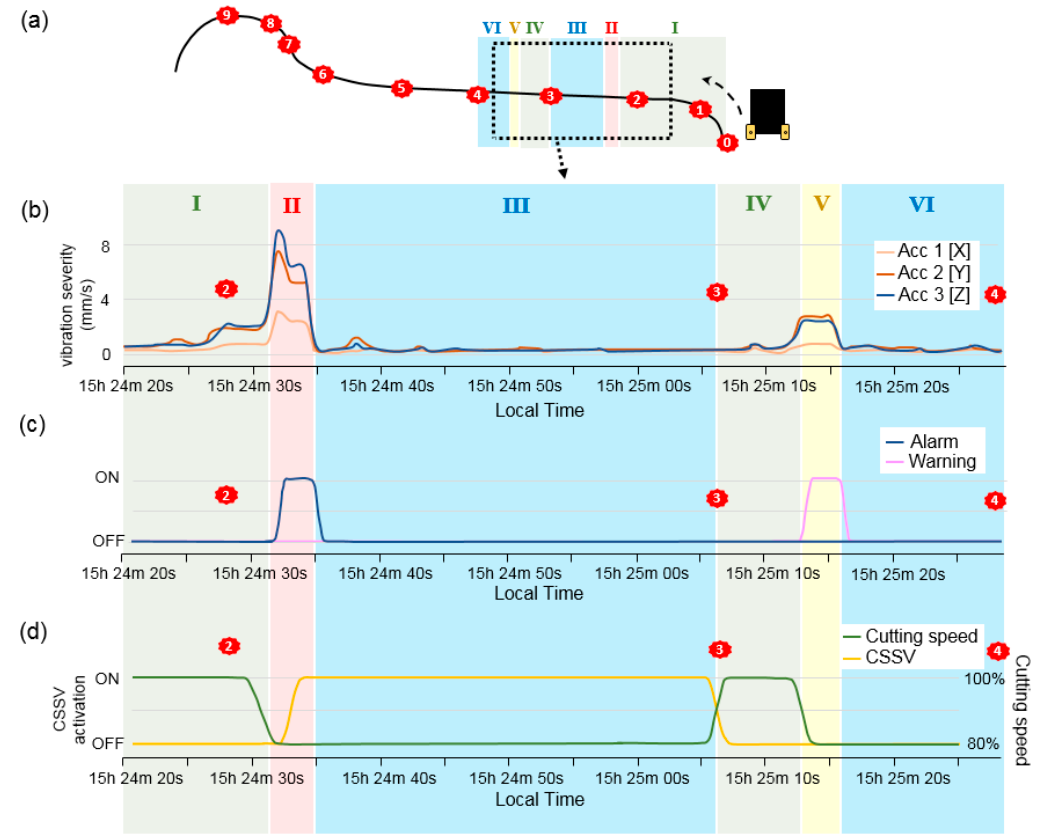
Figure 14. Chatter detection and suppression system performance, analyzed at the data visualization block: ( a ) wheel profile and tool trajectory; ( b ) vibration severity; ( c ) warnings and alarms; ( d ) activation of CSSV and the spindle speed (override percentage).